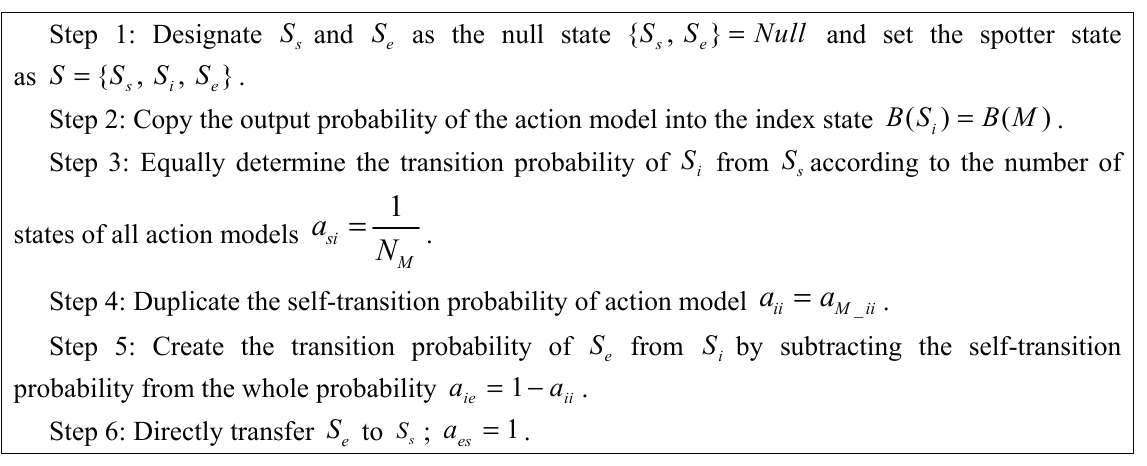
Figure 8. Ergodic model structure of HMM: ( a ) fully connected structure; ( b ) simply connected structure. Box 2. Spotter model creation